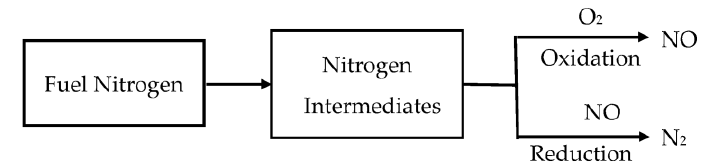
Figure 1. A simplified model of fuel NOx formation pathway.